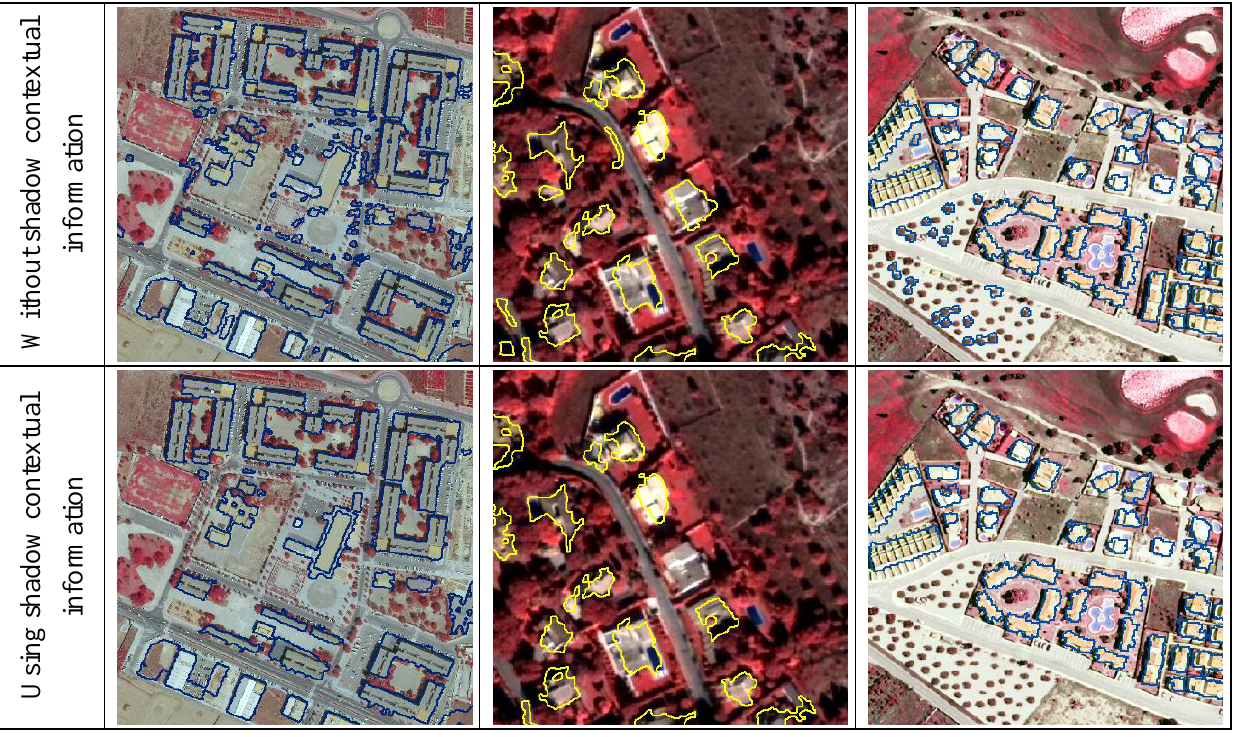
Figure 8. Detection examples of urban buildings in Sagunto (left) and suburban buildings in Moncada (center) and Oliva (right), showing differences due to the use of shadow contextual